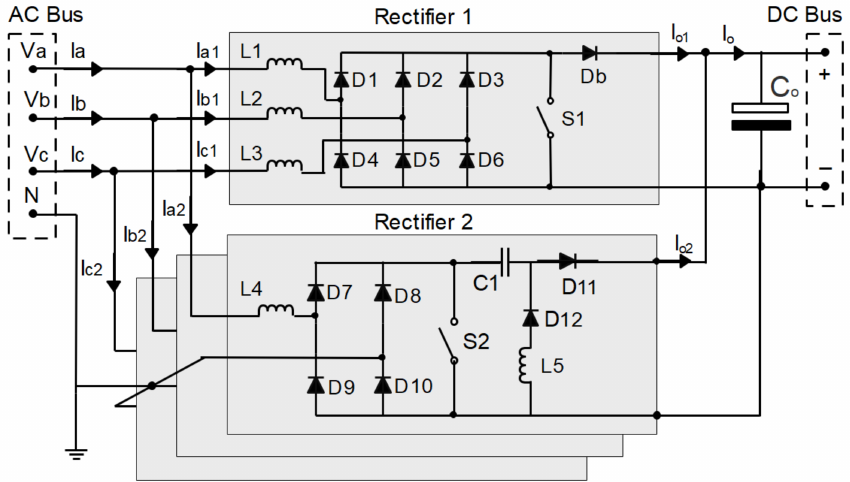
Figure 19. Configuration of the electrical circuit of UHTR-BR1//SR2.